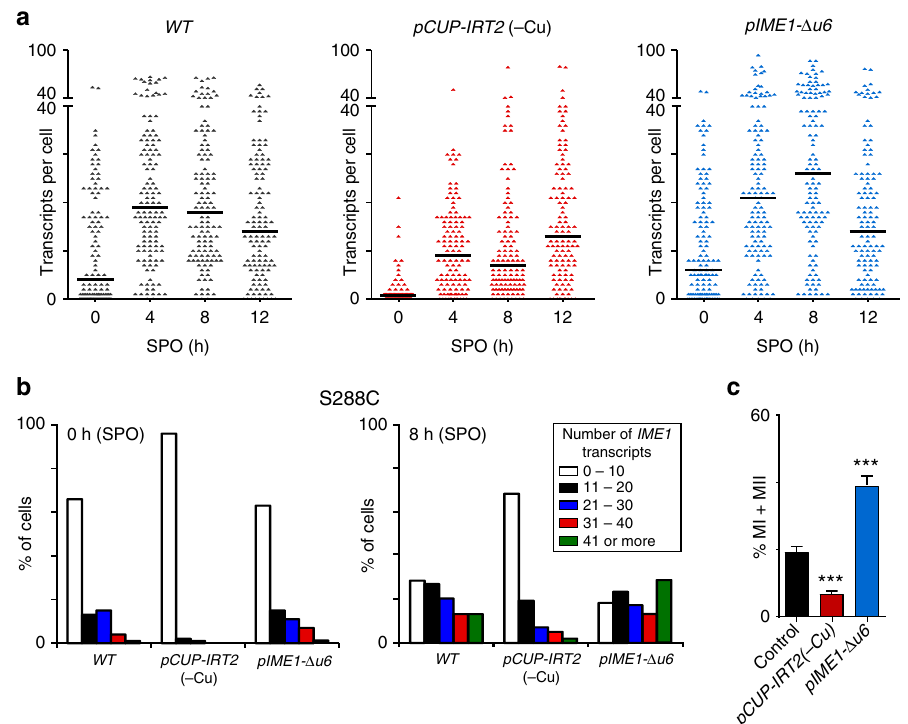
Fig. 6 Distribution of IME1 expression among single S288C cells in the presence or absence of IRT2 transcription. a Distribution of IME1 transcripts levels among single cells during entry into meiosis in S288C as detected by single-molecule RNA fl uorescence in situ hybridization. Wild-type (WT) (FW631), pCUP-IRT2 (FW2668), and pIME1- Δ u6 (FW1390) cells were grown in rich medium till saturation and subsequently shifted to SPO. Samples were taken at the indicated time points, fi xed, and hybridized with probes directed against IME1 and ACT1 mRNAs (see supplemental information for details). The black line indicates the median number of transcripts per cell for each time point. At least n = 120 cells were used for the analysis. b Same as a , but cells were binned according IME1 expression levels. c Quanti fi cation of cells that completed meiotic divisions in S288C cells described in a . Cells were fi xed after 72 h in SPO, stained, and DAPI masses were counted. The means ± SEM of at least n = 5 experiments are shown. *** p < 0.0005 (Student ’ s t >50% reduced compared to wild-type cells (Fig. 6c). Conversely, a higher fraction of cells completed meiosis when expression of IRT2 was increased (40% compared to 19% for the wild type). We conclude that the regulatory circuit consisting Ime1, IRT2 , and IRT1 directs the cell fate decision whether or not to enter meiosis.